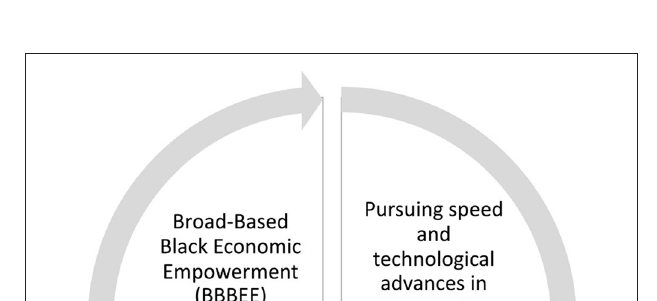
FIGURE 1 | Industry 4.0 business practices sustainably.